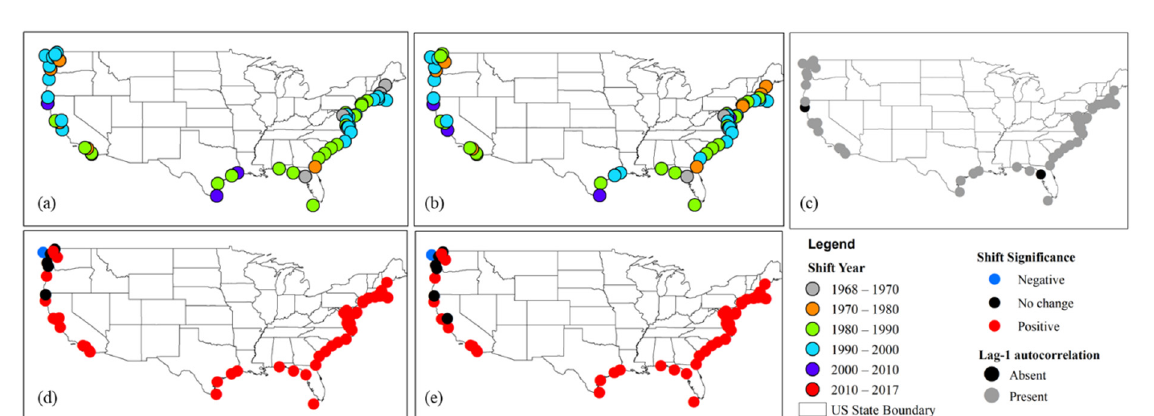
Figure 4. Spatial plots showing the results for the shift of annual sea level along the coastal US. Represents ( a ) Shift year before accounting for autocorrelation ( b ) Shift year after accounting for autocorrelation ( c ) Lag-1 autocorrelation ( d ) Shift significance year before accounting for autocorrelation ( e ) Shift significance year after accounting for autocorrelation. The red circle represents an increasing/positive trend whereas the blue downward arrow represents a decreasing/negative trend. The black dot represents stations showing no trend at the statistical significance of p ≤ 0.05.